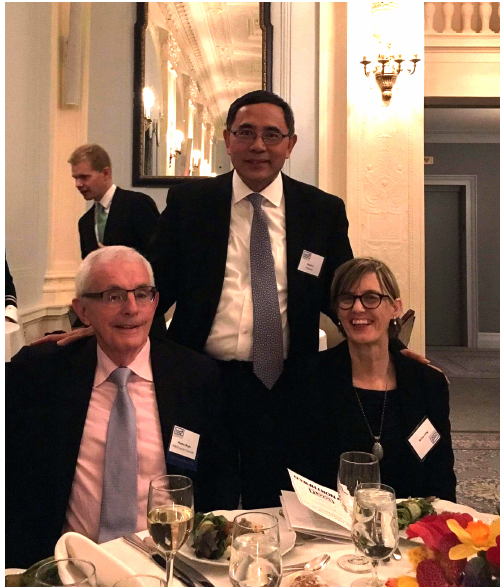
Figure 1: Phelim Boyle, David Li, and Mary Hardy in